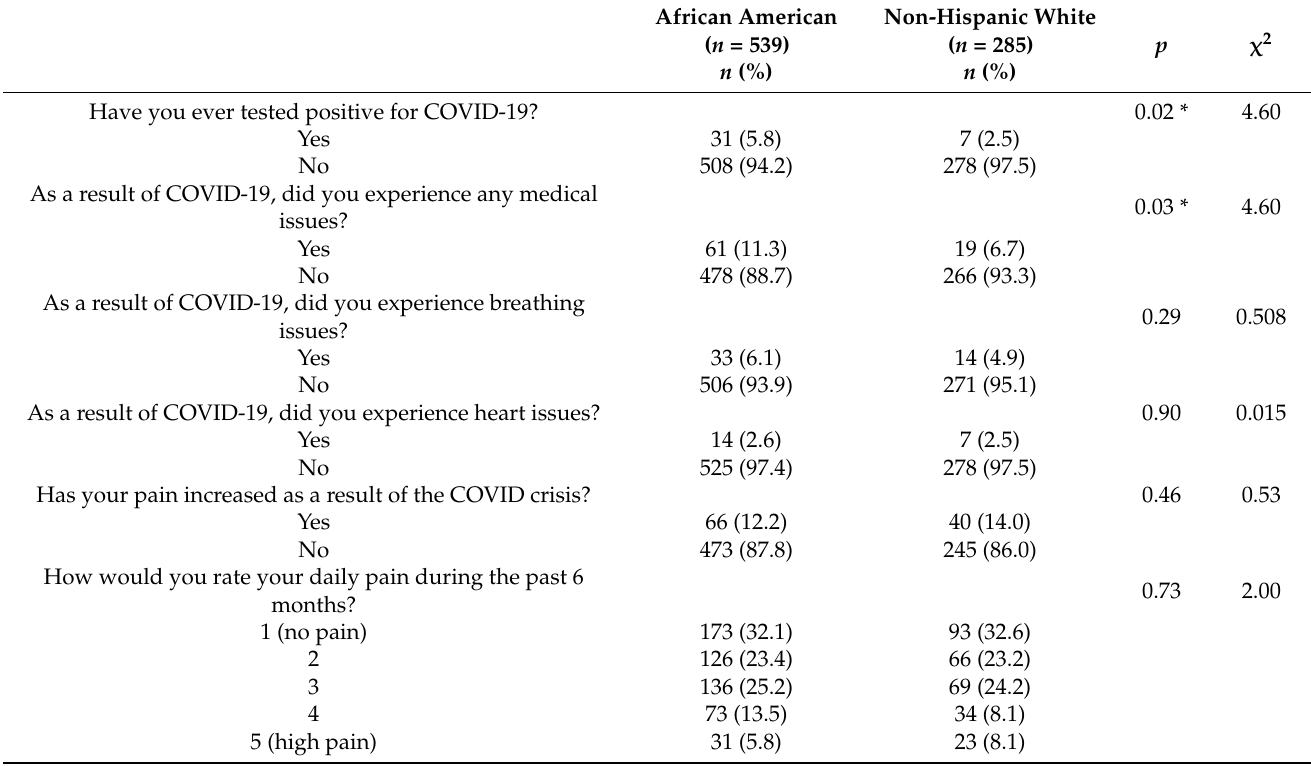
Non-Hispanic White African American p χ 2 ( n = 285) ( n = 539) n (%) n (%)